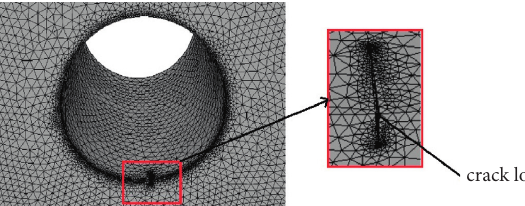
Figure 8: RPV submodel with postulated crack in FRANC3D.